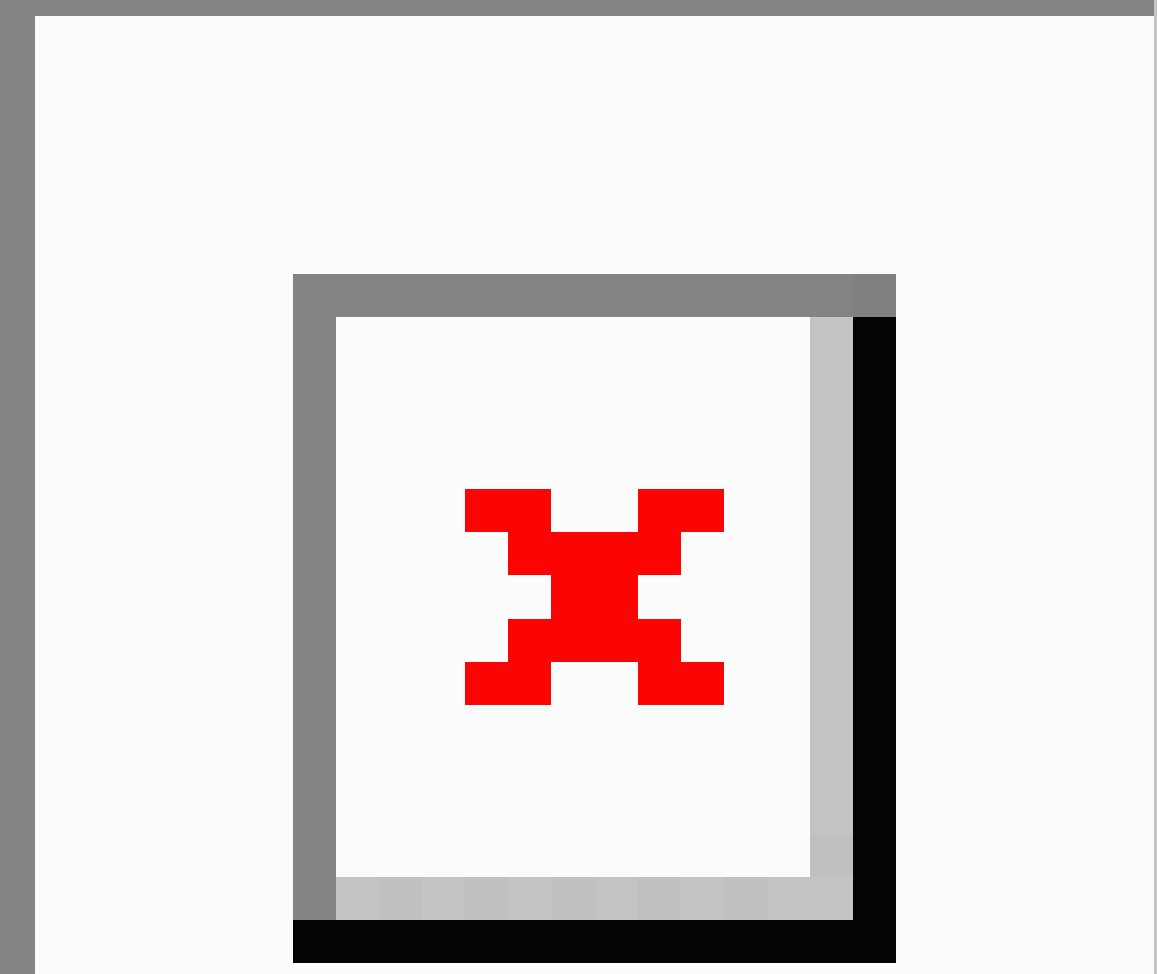
Figure 1. Expectations of applying telemonitoring and experienced differences after implementation of